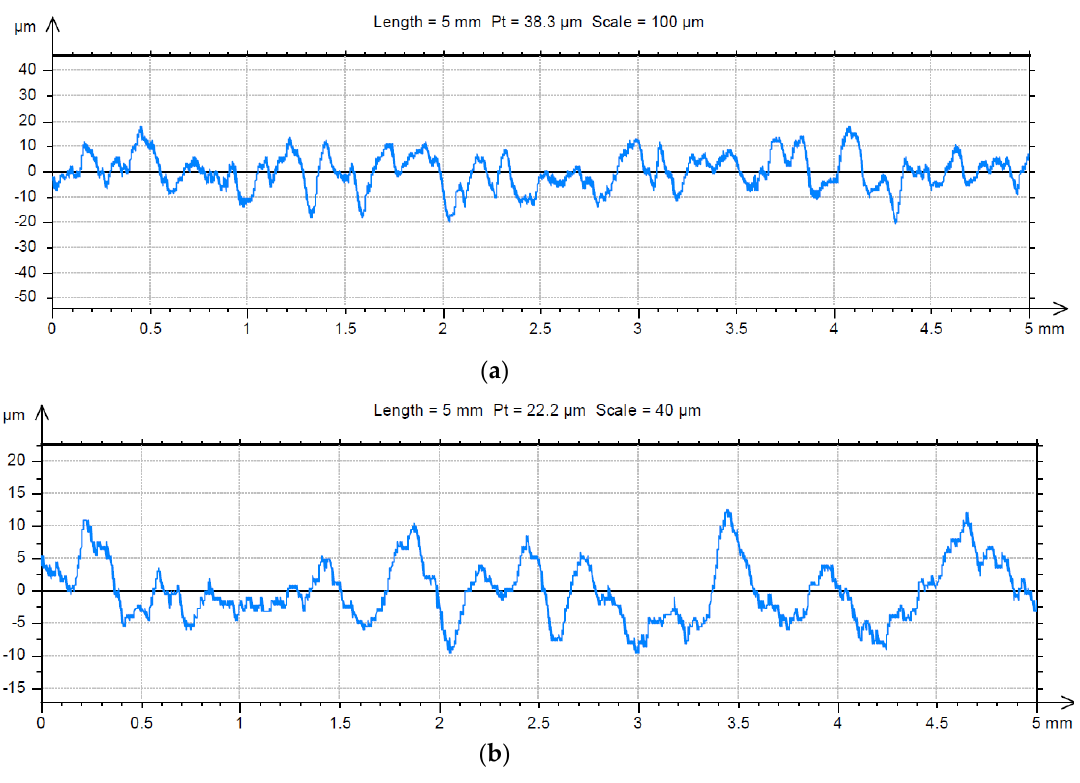
Figure 11. Representative profile lines for the reference material (PVC) ( a ) and biofilm coated material ( b ).